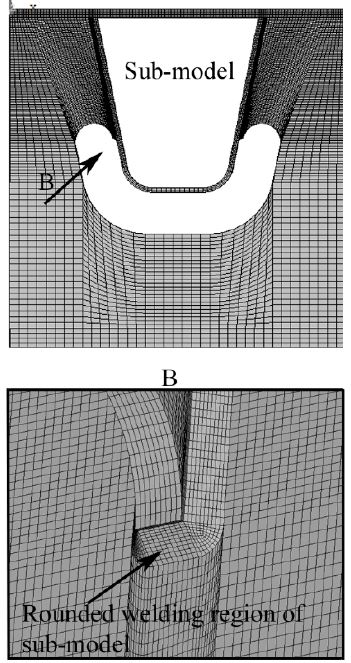
Figure 4. Sub-model of the rounded welding region.